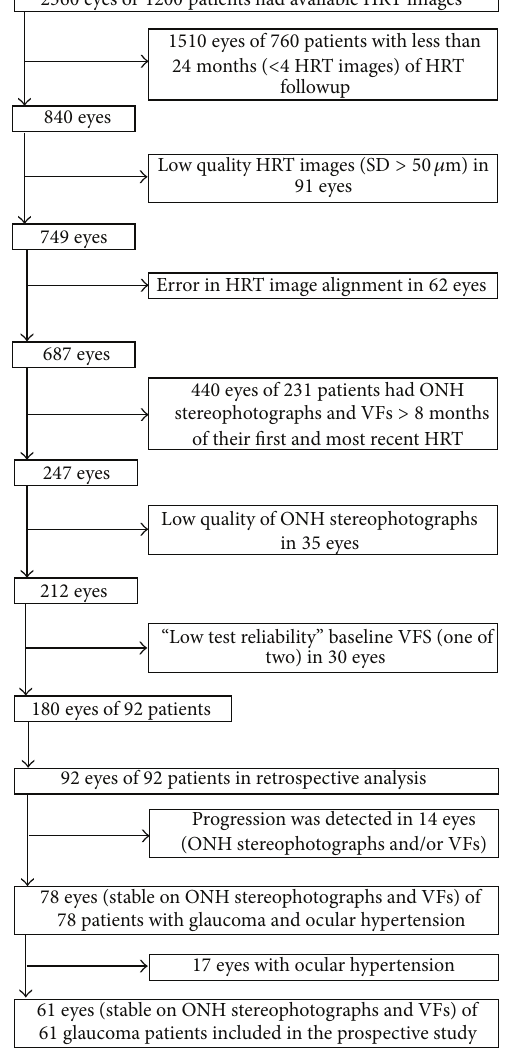
Figure 1: Flow chart showing study exclusion